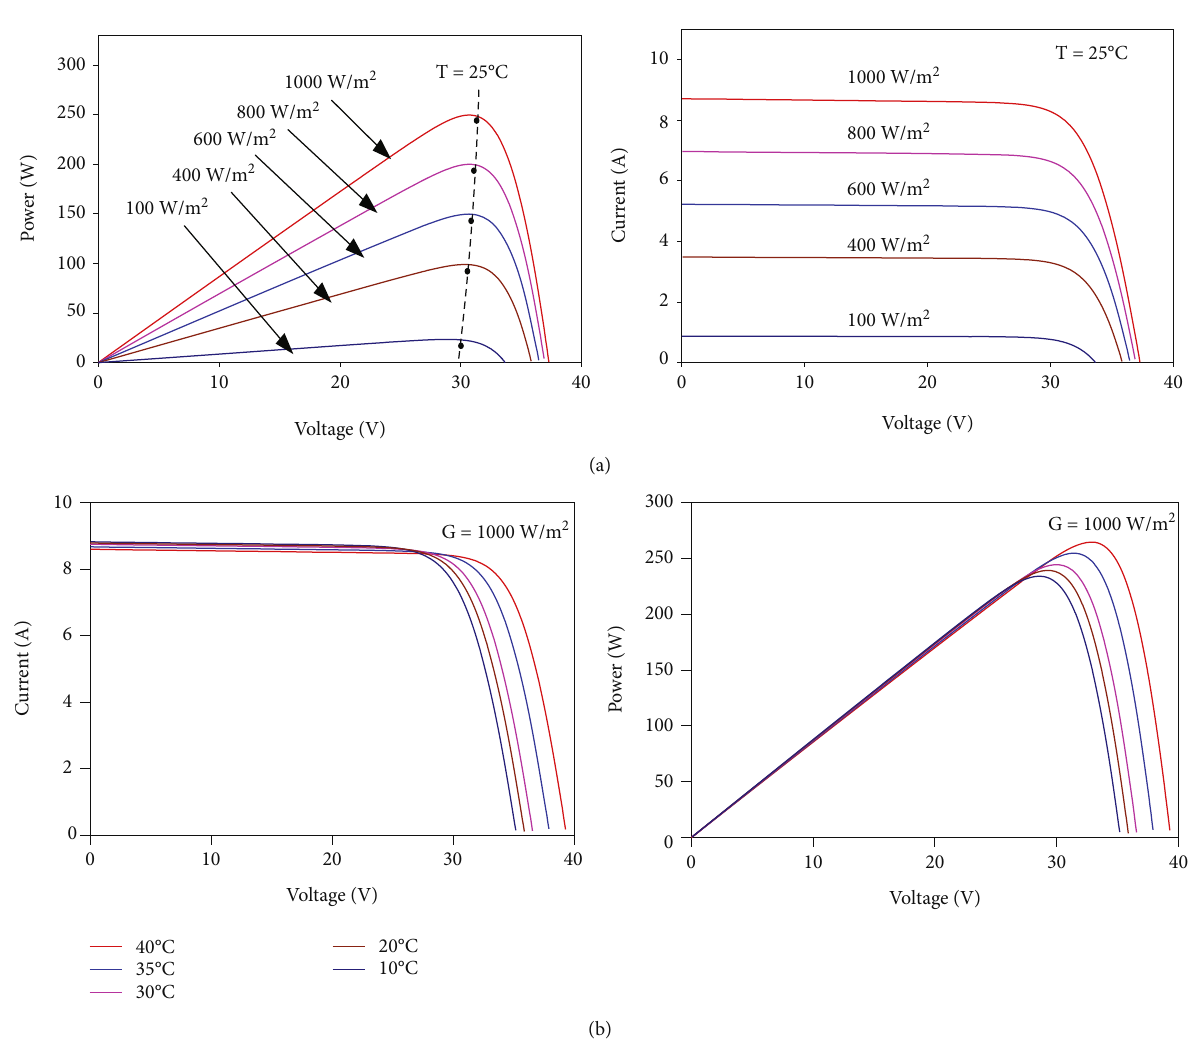
Figure 3: Characteristic of PV array at (a) changing G and (b) changing T .